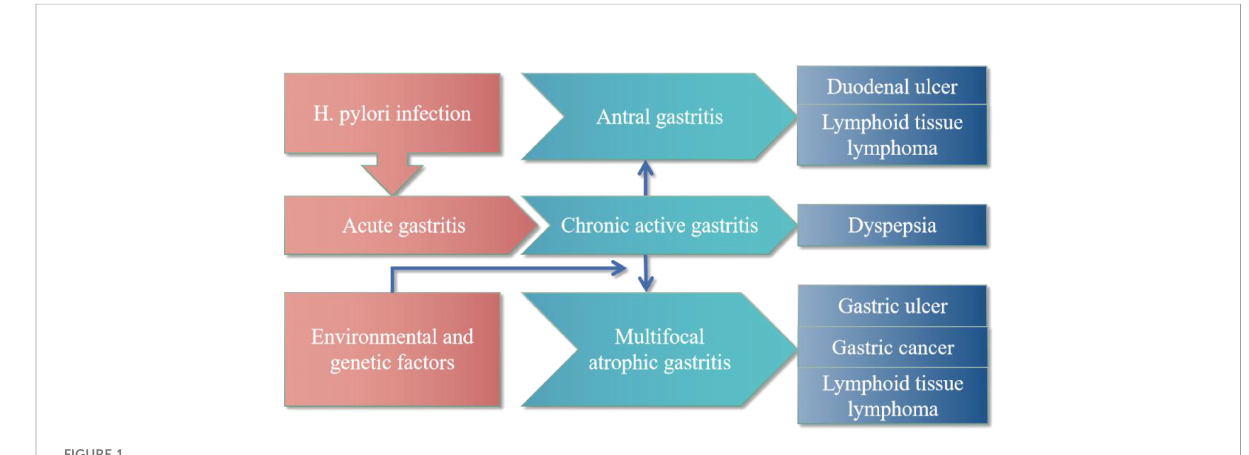
FIGURE 1 Gastrointestinal disease outcomes of H. pylori